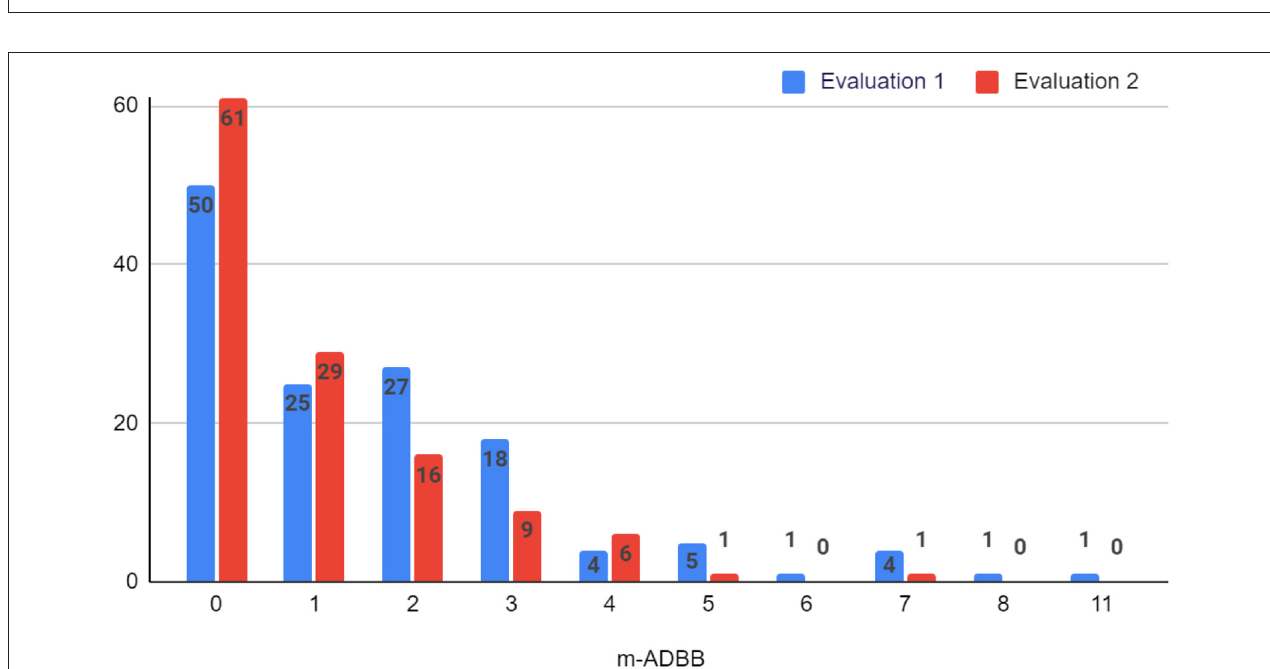
FIGURE 3 | Frequencies of the total scores of the m-ADBB scale.